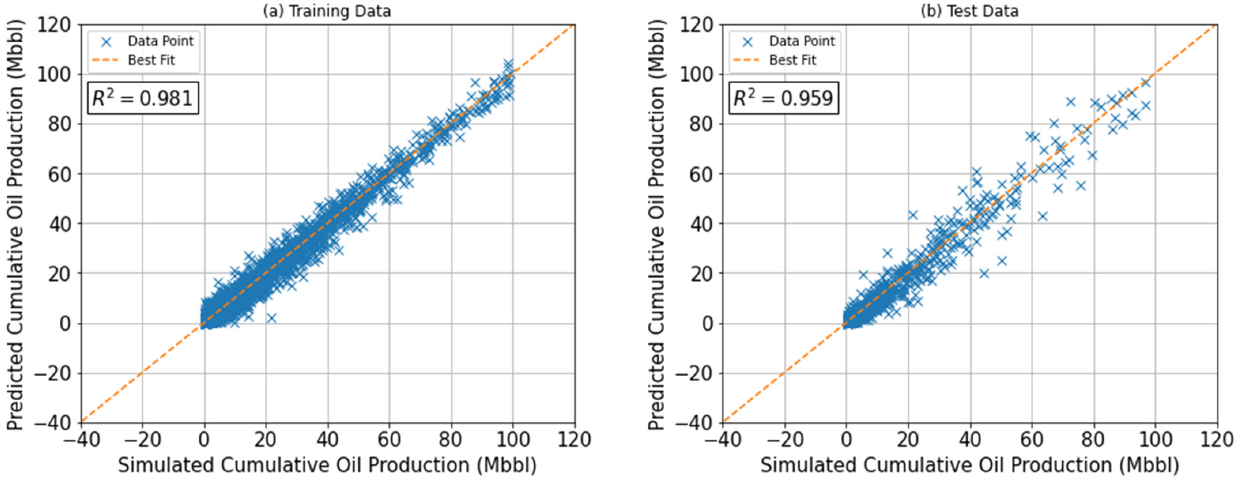
Figure 6. Predicted and simulated plot of ( a ) training data and ( b ) testing data for cumulative oil production—neural network model.